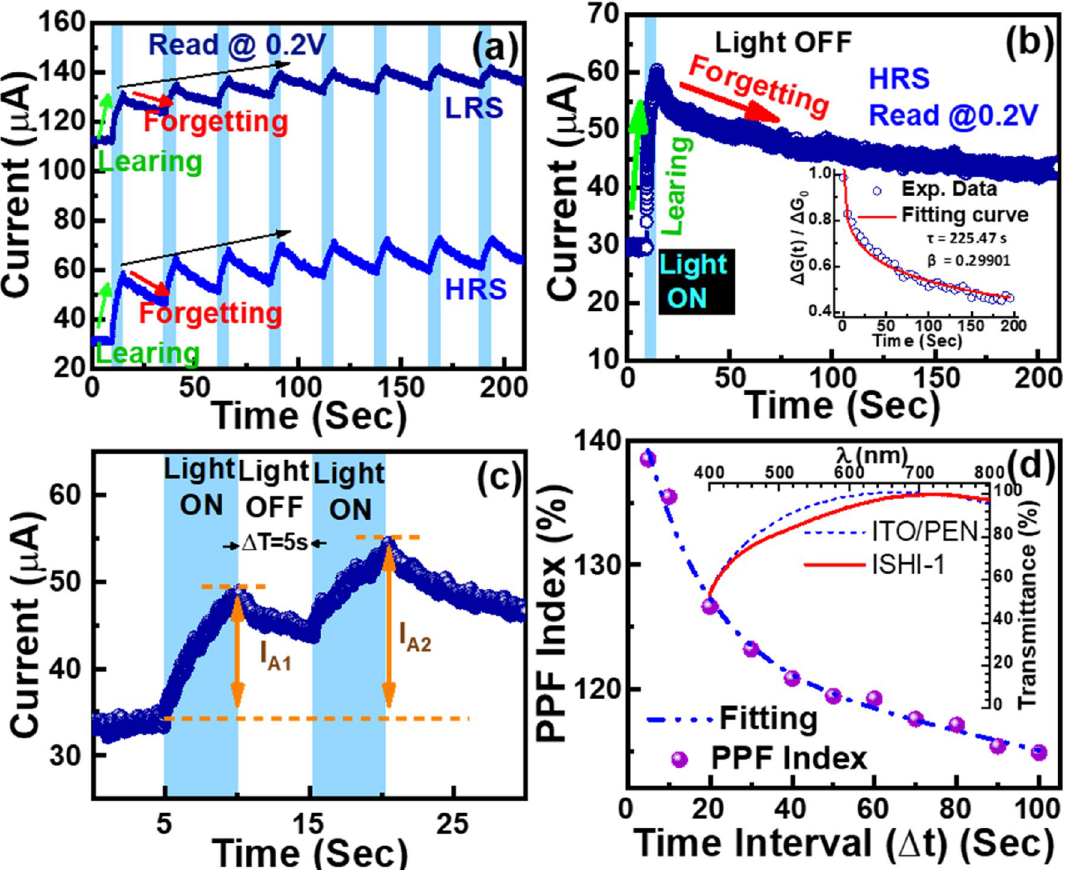
Figure 3. ( a ) Multi-level photocurrent states at LRS/HRS with typical blue light irradiation for 5 s followed by 20 s dark relaxation of eight cycles for ISHI-1 device. ( b ) Typical optoelectronic sensitivity at HRS after 5 s illumination and 200 s relaxation to achieve steady-state forgetting for the device. Inset shows the fitting result of the forgetting curve of the optoelectronic synapse during dark relaxation. ( c ) Pulse pair photo response under blue light irradiation, 5 s exposure with 5 s time intervals. ( d ) Photonic PPF index (I A2 /I A1 ) with Δt between consecutive pulses with the simulated curve, inset showing the normalised transmittance spectra comparison of the ISHI-1 device with the commercial